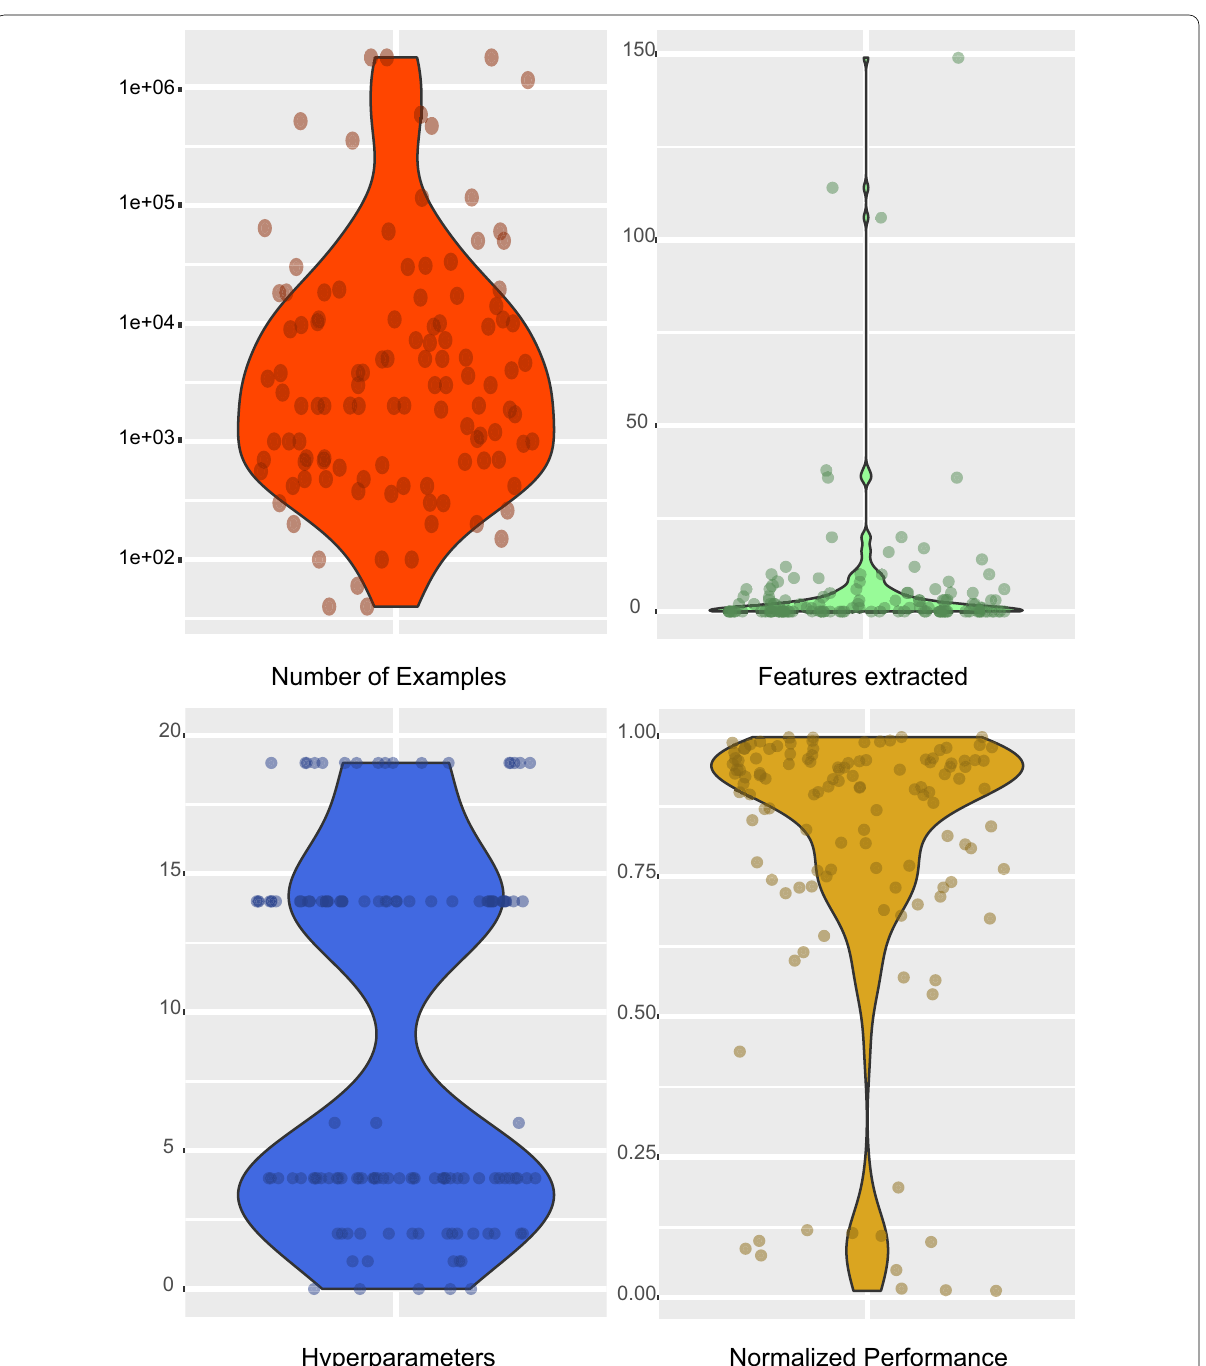
Fig. 9 Distribution of the four characteristics from all the collected